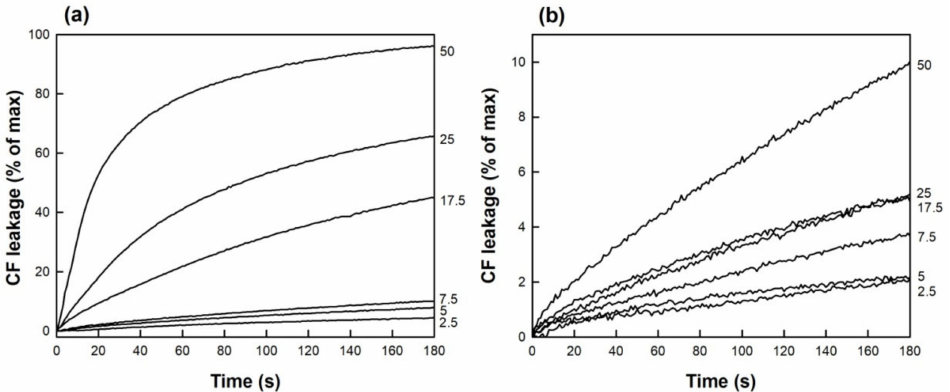
Figure 2. CF leakage curves from POPC LUV upon addition of ( a ) TMX or ( b ) HTMX. Numbers on the right of the traces indicate drug concentrations in µ M. Total phospholipid concentration was 20 µ M, and temperature was thermostated to 25 ◦